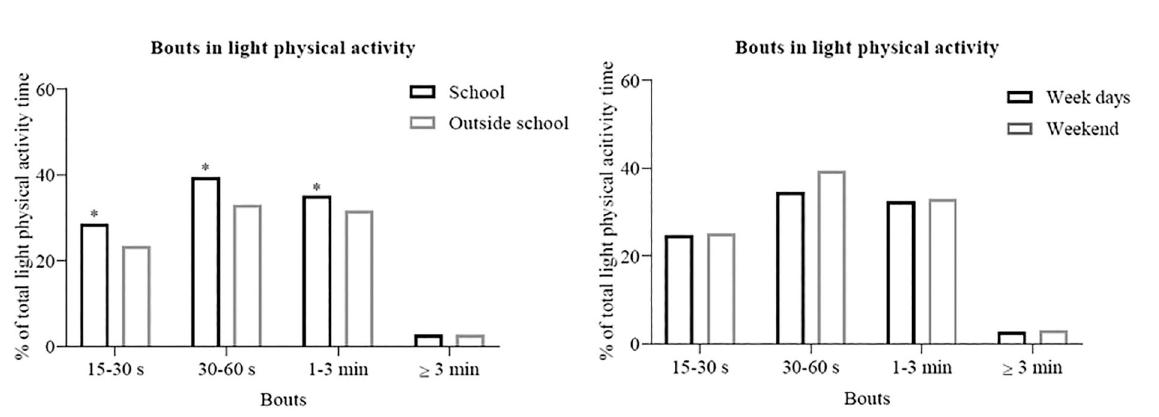
Figure 2 - Pattern of light physical activity according to bouts for weekdays or weekends and in or outside school. * P < 0.05.